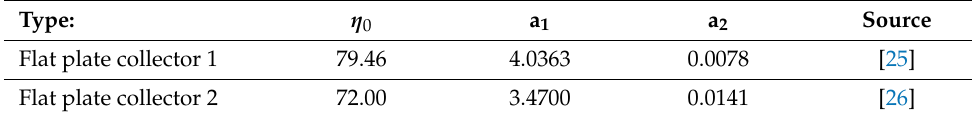
Table 8. Characteristics of collector parameters.